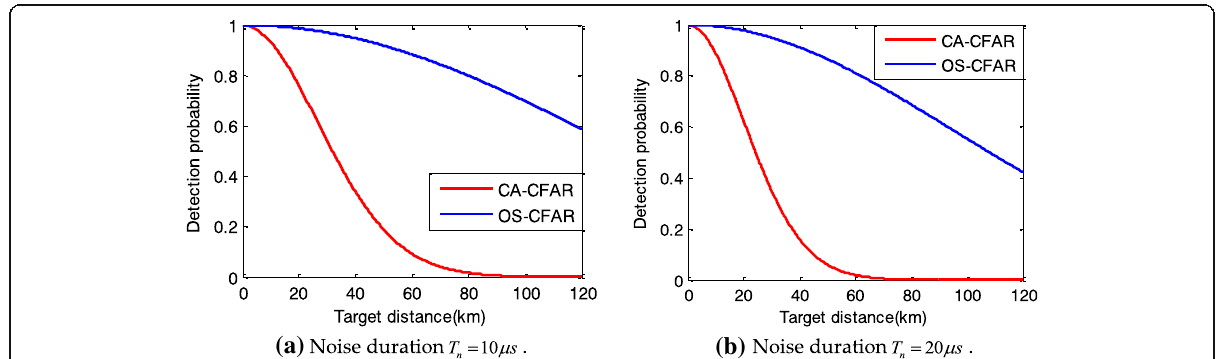
Fig. 8 Effect of noise frequency modulation power-cooperative jamming on two detectors ’ performances. a Noise duration T n = 10 μ s. b Noise duration T n = 20 μ